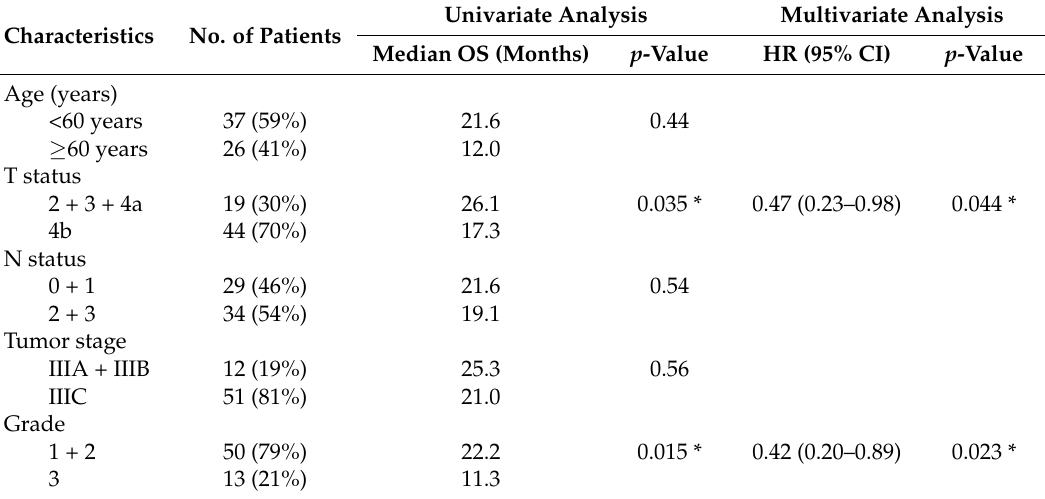
Univariate and multivariate analysis of overall survival in 63 patients with locally advanced stage III cervical esophageal squamous cell carcinoma who received curative concurrent